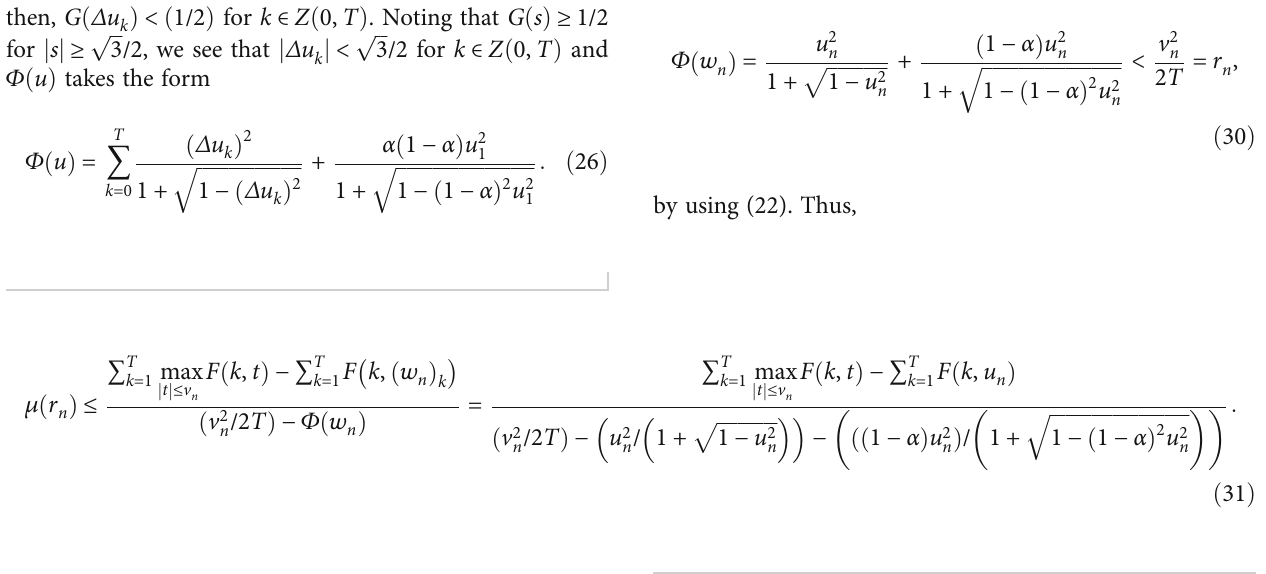
p(cid:3) (cid:4)(cid:3) (cid:4) ffiffiffiffiffiffiffiffiffiffiffiffi − 1 − u 2 n